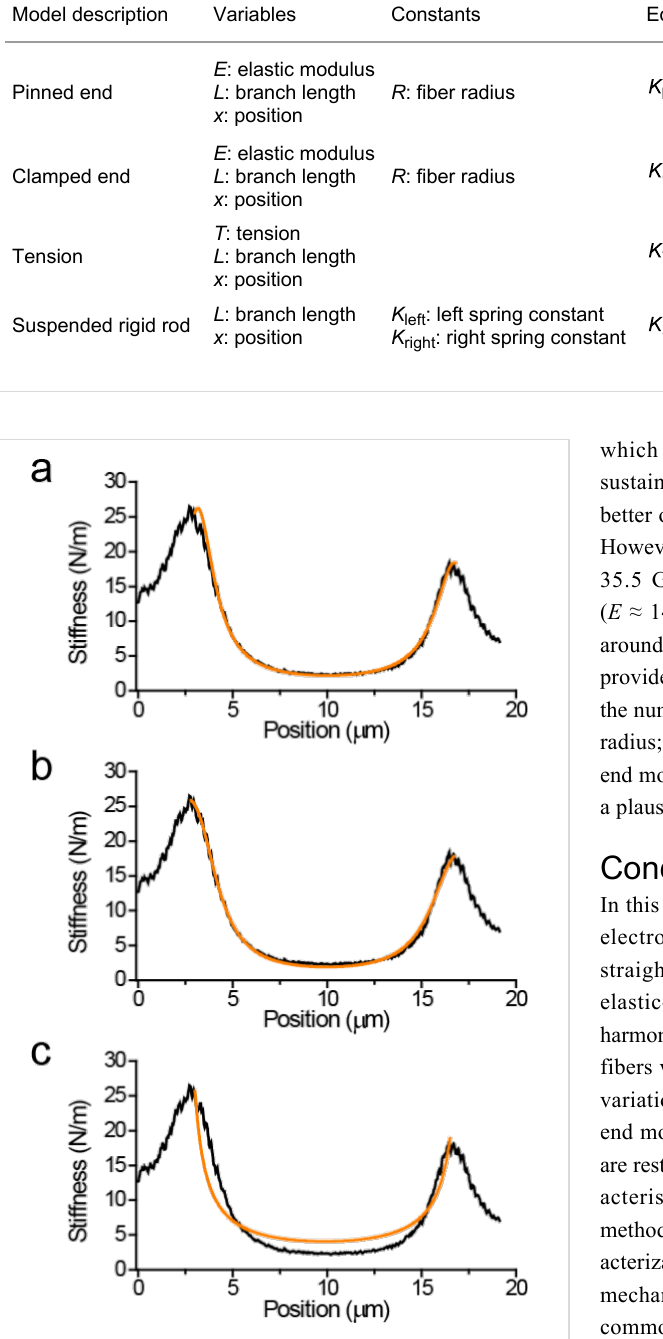
measured spring-constant profile. However, the tension model did not produce a good overall fit to the data. The tension value calculated as 16.7 µN translates to a tensile stress of ≈ 78.6